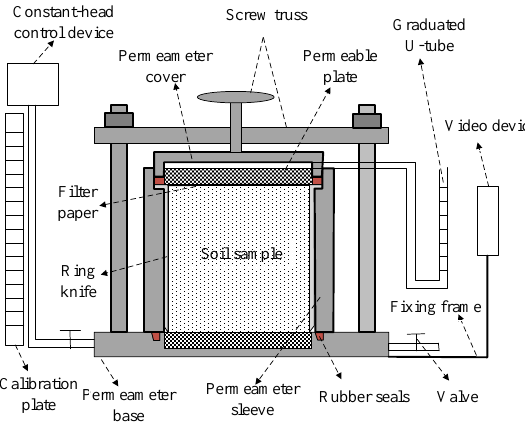
Figure 2. Schematic diagram of the improved constant-head permeability test device.